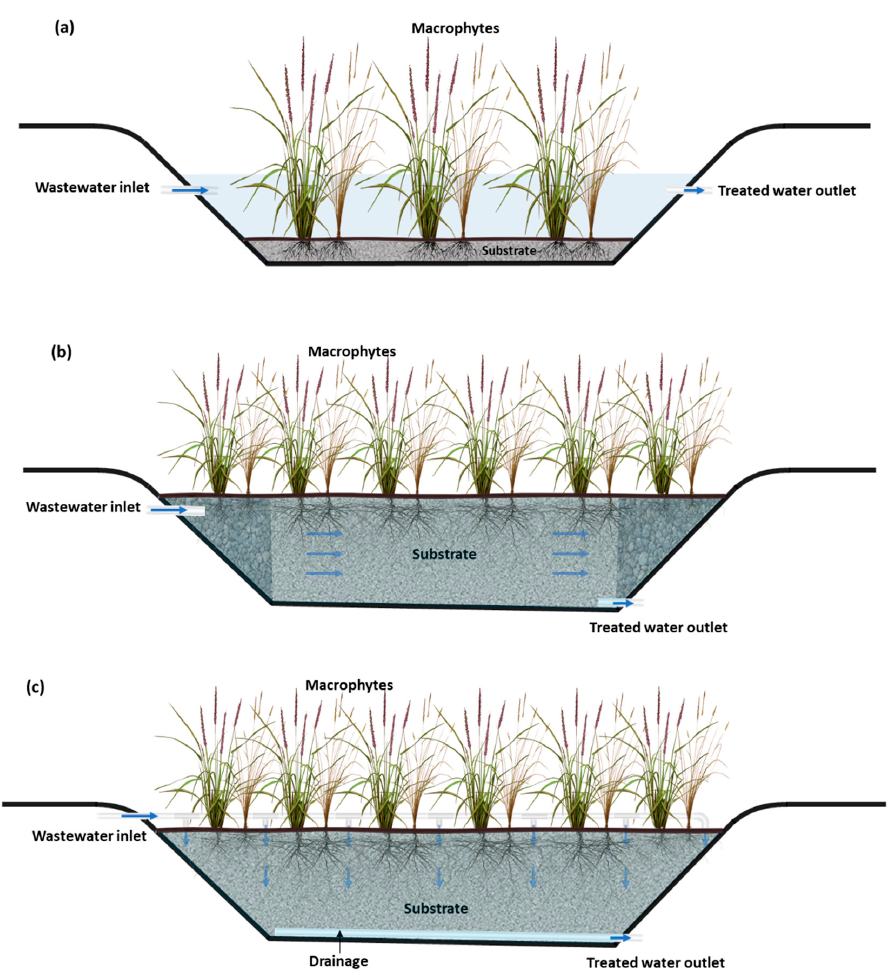
Figure 1. Free water surface CW ( a ); horizontal subsurface flow CW ( b ); vertical subsurface flow CW ( c ).